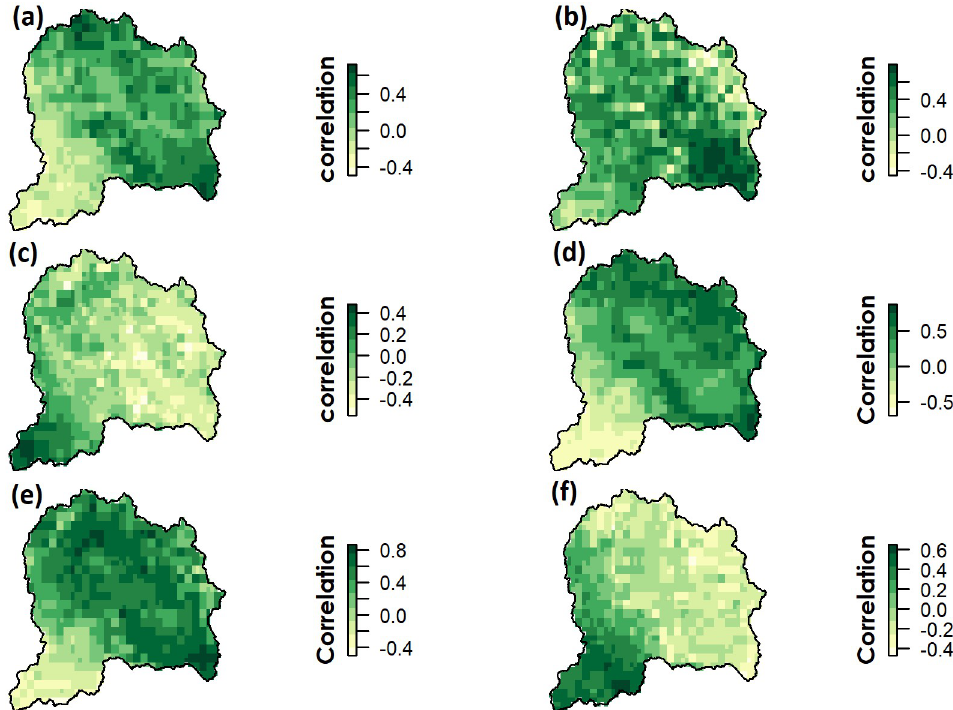
Fig 7. Annual correlation coefficient of NDVI with Tmax (a) Tmin (b) and precipitation (c). Similarly, correlation coefficient of NDVI with Tmax (d) Tmin (e) and Precipitation (f) in spring (Q2) over the UJRB during